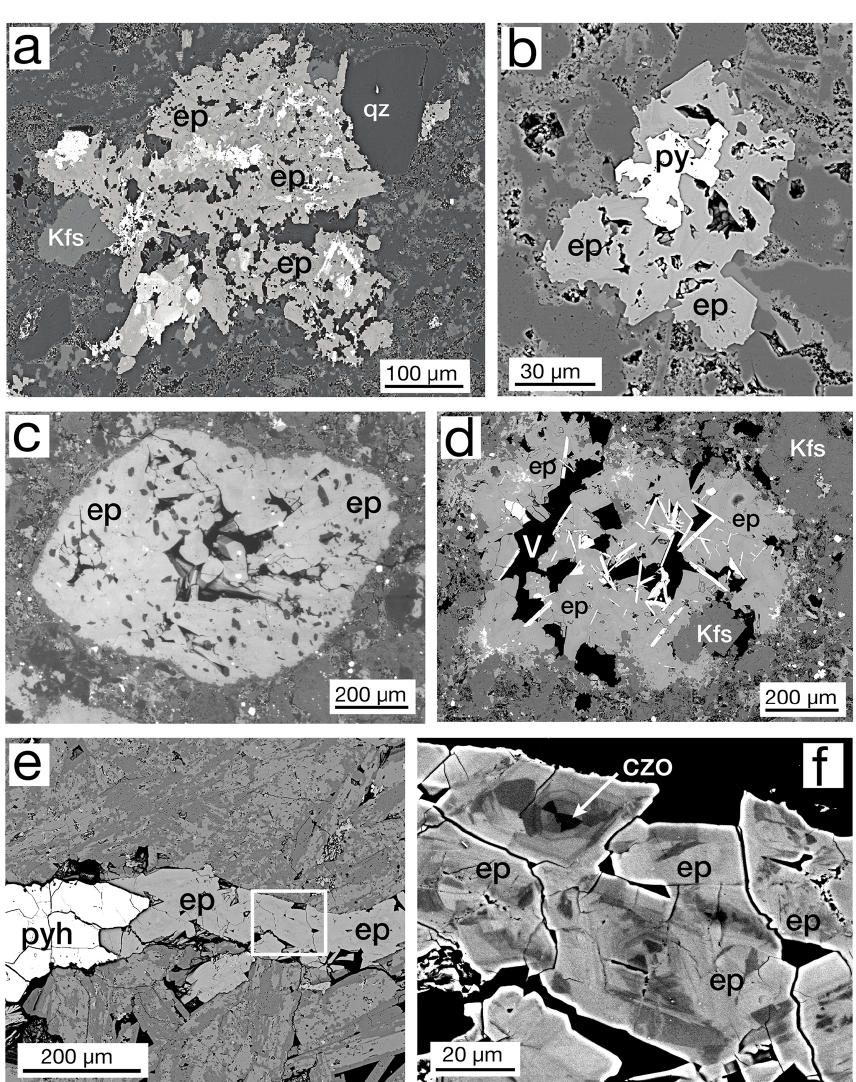
Figure 4. BSE images: (a) typical irregularly shaped mass of epidote (ep) crystals with quartz (qz) and K-feldspar (Kfs) from sample MF1- 1597. Details of the bright core area are shown in Fig. 9f. (b) Mass of epidote crystals (ep) with pyrite (py), sample MF1-1495. (c) Probable vesicle filled with epidote (ep), sample SV1-2510. (d) Open cavity partially filled (V – vug) with epidote (ep) and potassium feldspar (Kfs) with hematite blades (high BSE), sample SV1-2510. (e) Portion of a > 2cm pyrrhotite (pyh), clinozoisite, and epidote vein. Box enlarged in (f) , sample MF2-1824. (f) Enlarged area imaged with high BSE contrast to show complex patchy zoning of epidote (ep) and clinozoisite